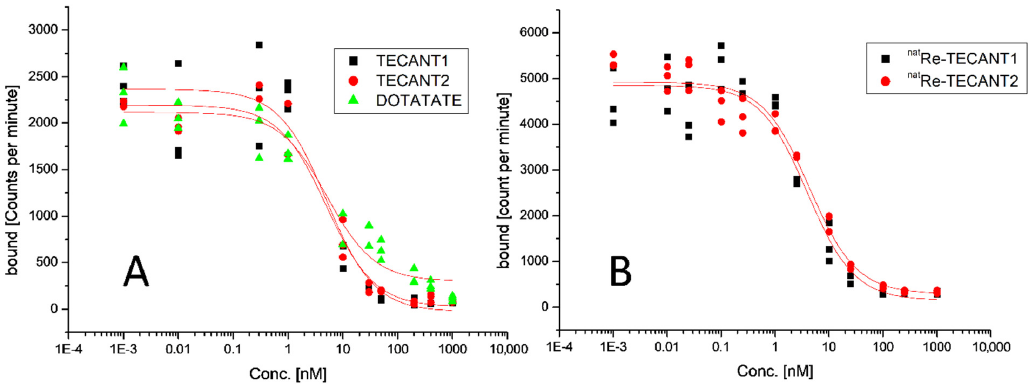
Figure 3. ( A ) Competition assay for determination of apparent half maximal inhibitory concentration (IC 50 ) of TECANT-1 and TECANT-2, compared to DOTA 0 -Tyr 3 -Octreotate (DOTA-TATE). ( B ) Respective assay for the natural rhenium ( nat Re) complexes.